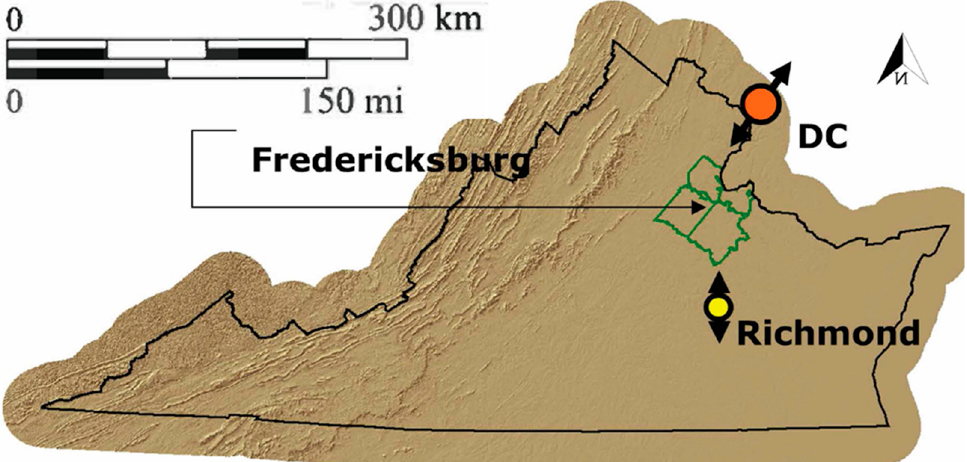
Figure 1. State of Virginia and Location of Study Area (FAMPO) (green lines).